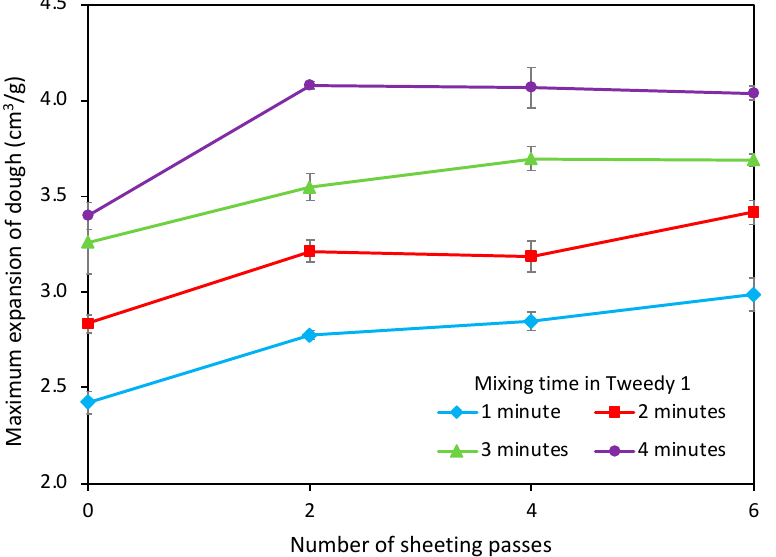
Figure 3. Maximum expansion against number of sheeting passes at a roll gap of 6 mm, following initial dough formation for 1, 2, 3 or 4 min in the Tweedy mixer.